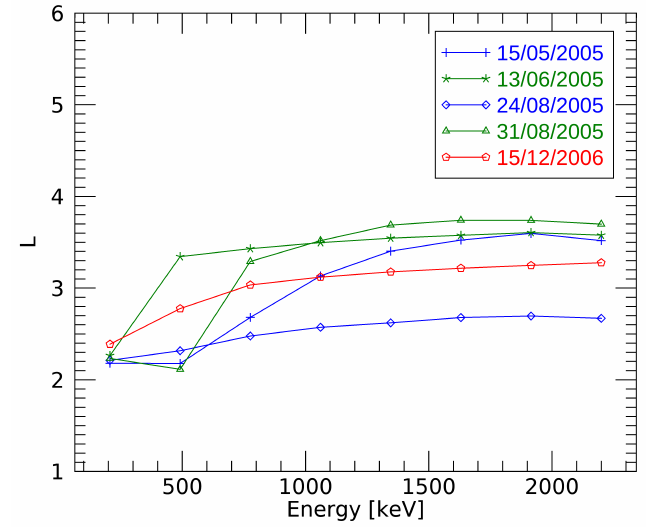
Figure 10. The impenetrable barrier L-shells as a function of energy for all five storms. The colors rep- resent the different storm types, blue being Type 1 storms, green Type 2 storms, and red corresponds to the special